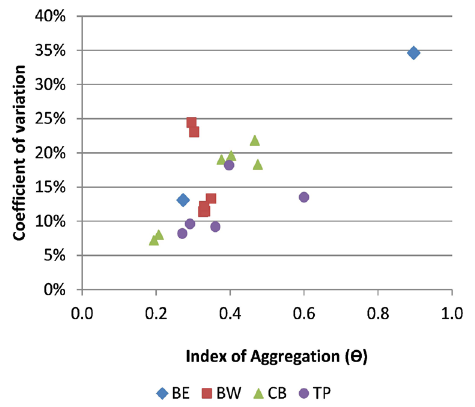
Figure 4. Relationship between Rivest estimator pre- cision and aggregation as estimated by the dispersion parameter of the negative binomial distribution ( θ ) for caribou herds in the Northwest Territories and Nunavut, Canada, 2000-2015. Estimates are dis- played from the Bluenose-East (BE), Bluenose-West (BW), Cape Bathurst (CB) and Tuktoyaktuk Penin- sula (TP)